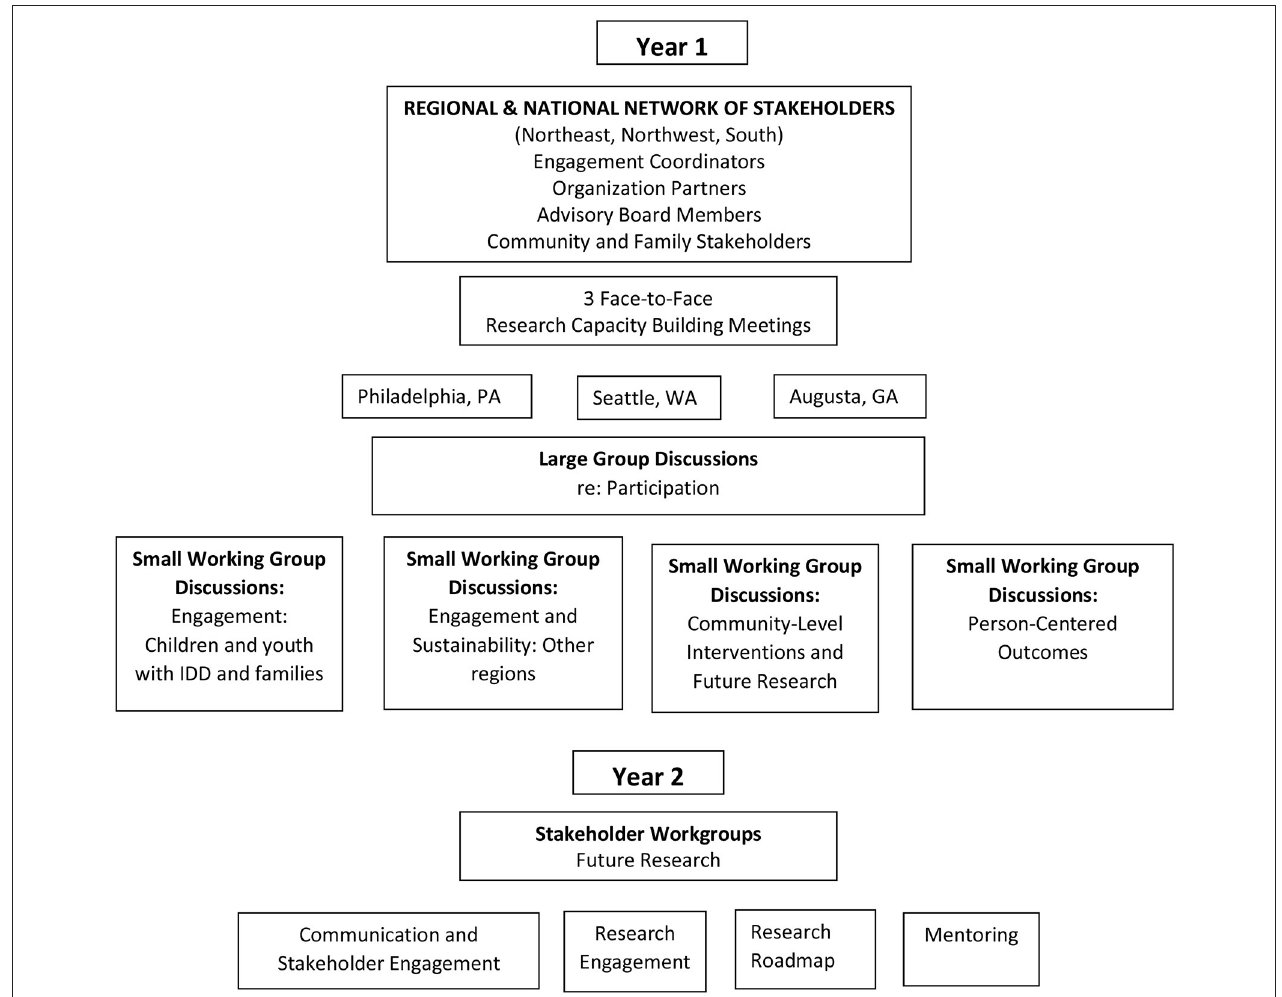
FIGURE 1 | Representation of methodology for research capacity building face-to-face